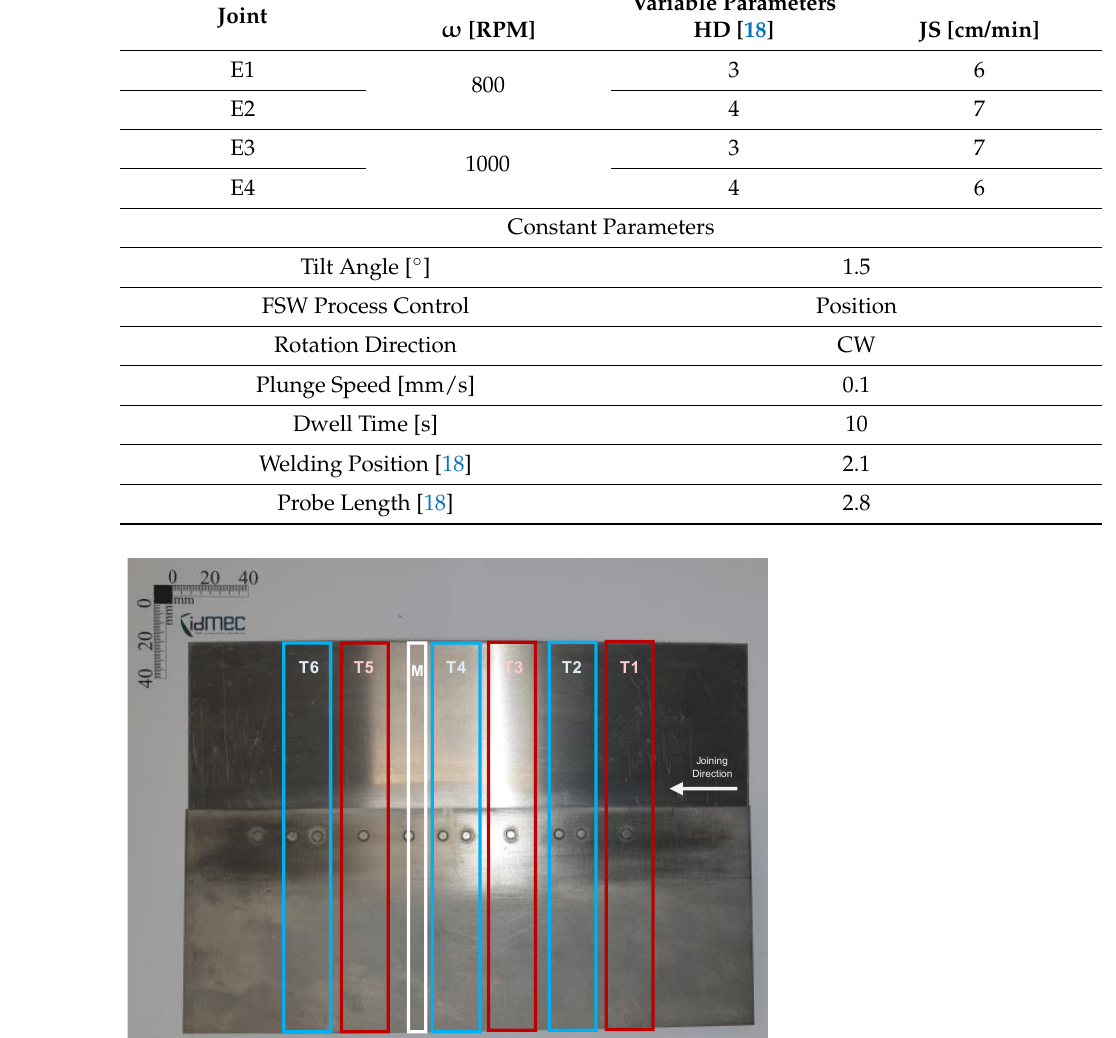
Figure 3. Back view of an AA-Ti produced joint, with a schematic representation of the location of the cut specimens. Joints with single and double connection points highlighted by red and blue rectangles, respectively.